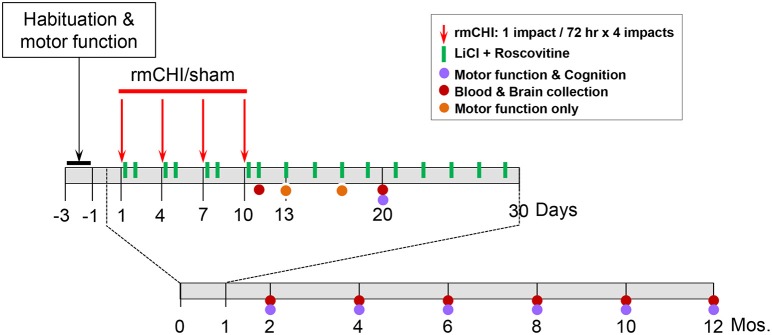
Schematic representation of the overall study design.